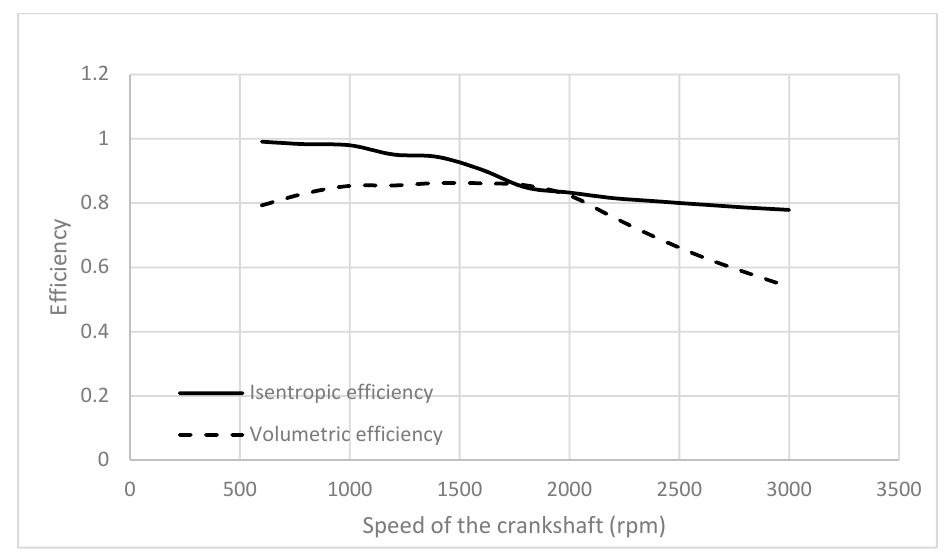
Figure 8. Performance of the optimized compressor under different speeds (at P o = 300 kPa).